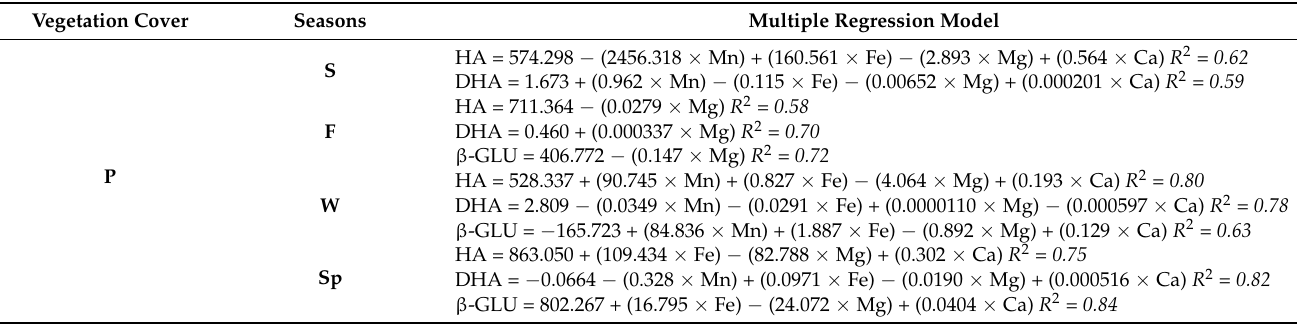
Table 5. Results of multiple linear regression analyses for soils under different vegetation covers and seasons. Signifi- cant results of multiple linear regression analyses of soil enzymatic activities (hydrolase: HA, dehydrogenase: DHA and β -glucosidase: β -GLU) in relationship with soil abiotic properties (pH, water content: WC, total concentration of carbon and nitrogen: C and N, organic matter content: OM, available fraction of Al, Ca, Cu, Fe, K, Mg, Mn, Na, and Pb) in soils under different vegetation cover (P: pine; HO: holm oak; BL: black locust; H: herbs) at different seasons (S: summer 2018; F: fall 2018; W: winter 2019; Sp: spring 2019). Italics indicate the adjusted R 2 of each model. Vegetation Cover Seasons Multiple Regression